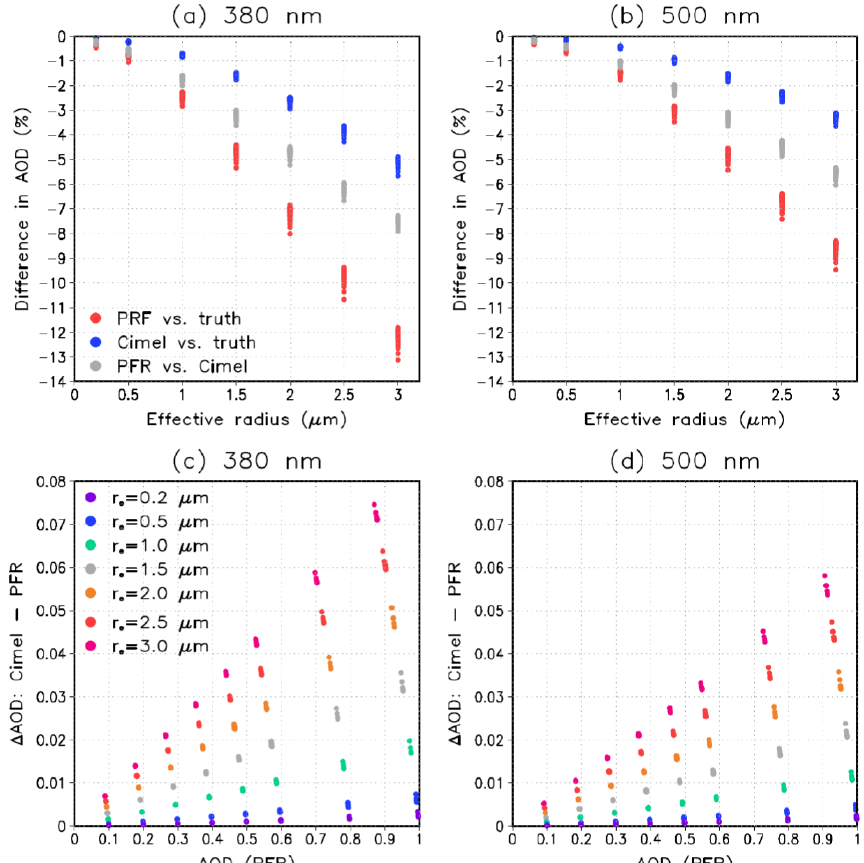
Figure 8. (a, b) The simulated relative differences in retrieved AOD (in percentage) that would result from the scattered radiation within the FOV of the PFR and Cimel instruments. The red (blue) dots show the differences between the AOD that would be retrieved using PFR (Cimel) and the actual AOD and the grey dots show the difference between PFR and Cimel at the (a) 380nm and (b) 500nm wavelengths. (c, d) The difference in retrieved AOD between PFR and Cimel, plotted as a function of the AOD retrieved with PFR, for seven values of aerosol effective radius between 0.2 and 3.0µm at (c) 380 and (d) 500nm.